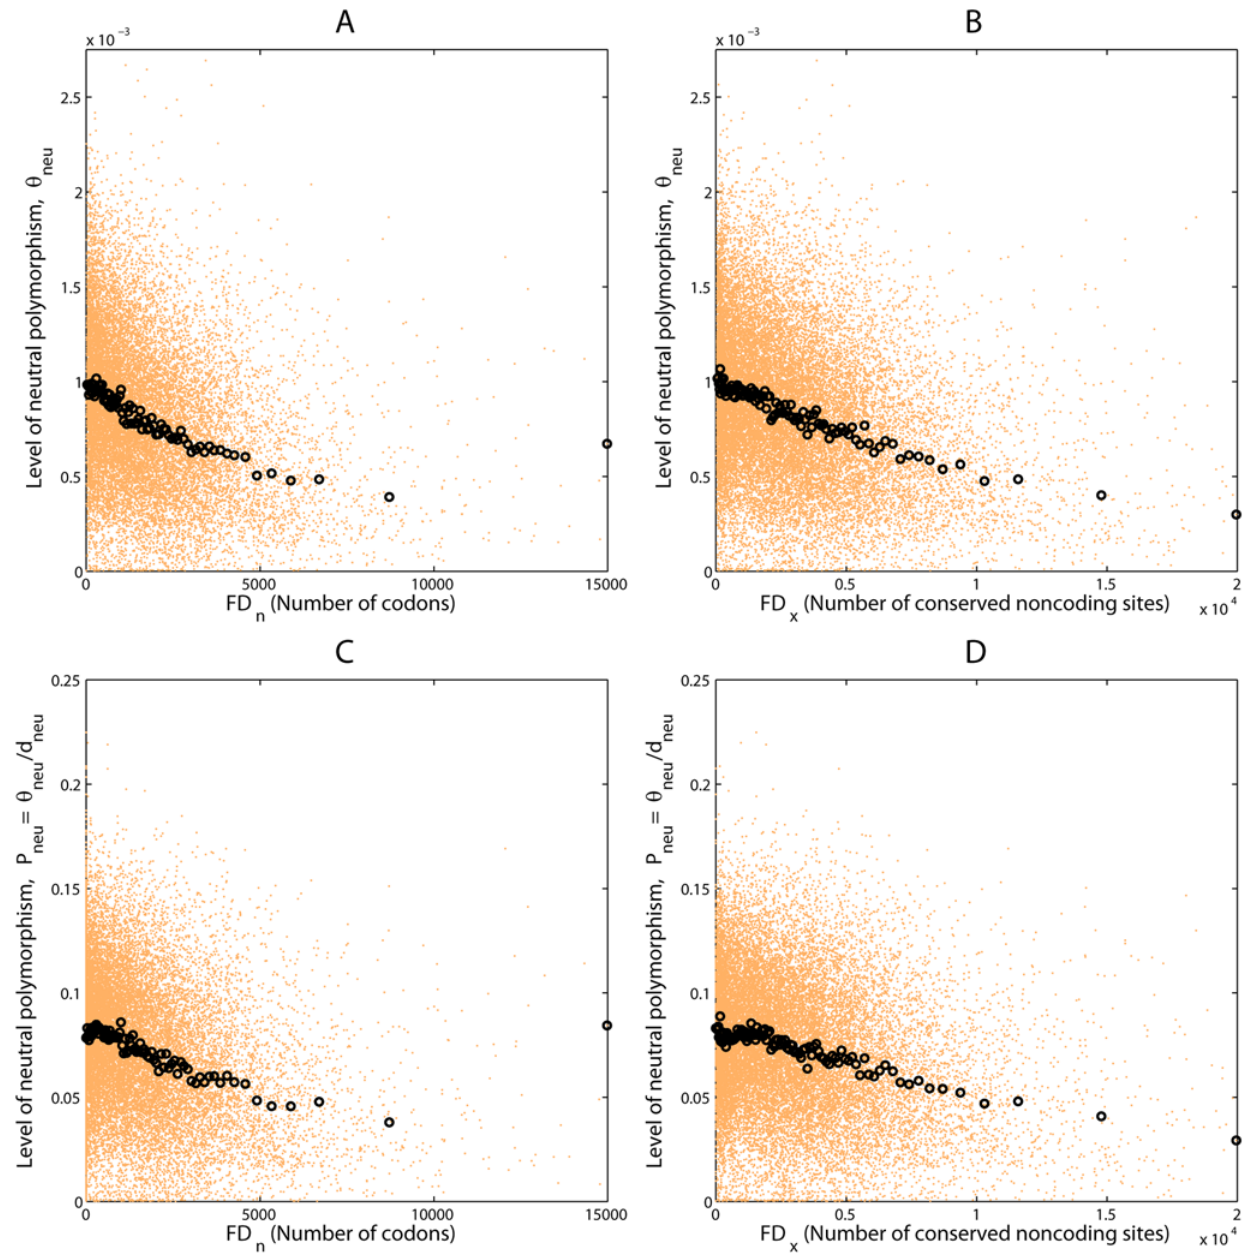
Figure 2. Relationships among the levels of functional density and neutral polymorphism. Scatter plots display values of two variables in orange dots for (A) the number of codons ( FD n ) and the level of neutral polymorphism ( h neu ), (B) the number of conserved noncoding sites ( FD x ) and the level of neutral polymorphism ( h neu ), (C) the number of codons ( FD n ) and the level of normalized neutral polymorphism ( P neu = h neu / d neu ), and (D) the number of conserved noncoding sites ( FD x ) and the level of normalized neutral polymorphism ( P neu = h neu / d neu ). Black circles are average values for orange dots pooled in 100 bins each containing 1% of the data points. doi:10.1371/journal.pgen.1000336.g002 Lower Levels of Neutral Polymorphism in the Regions of functional density ( FD n , FD x , or both) (Tables 3, S4). The correlations between either D n or D x and either of the two measures of neutral variation ( h neu or P neu ) remain statistically significant when we control/correct for the other measure of functional divergence (i.e. control for D n in the case of correlations of neutral diversity with D x and, similarly, control for D x in the case of correlations of neutral diversity with D n ) (Tables 3, S4).